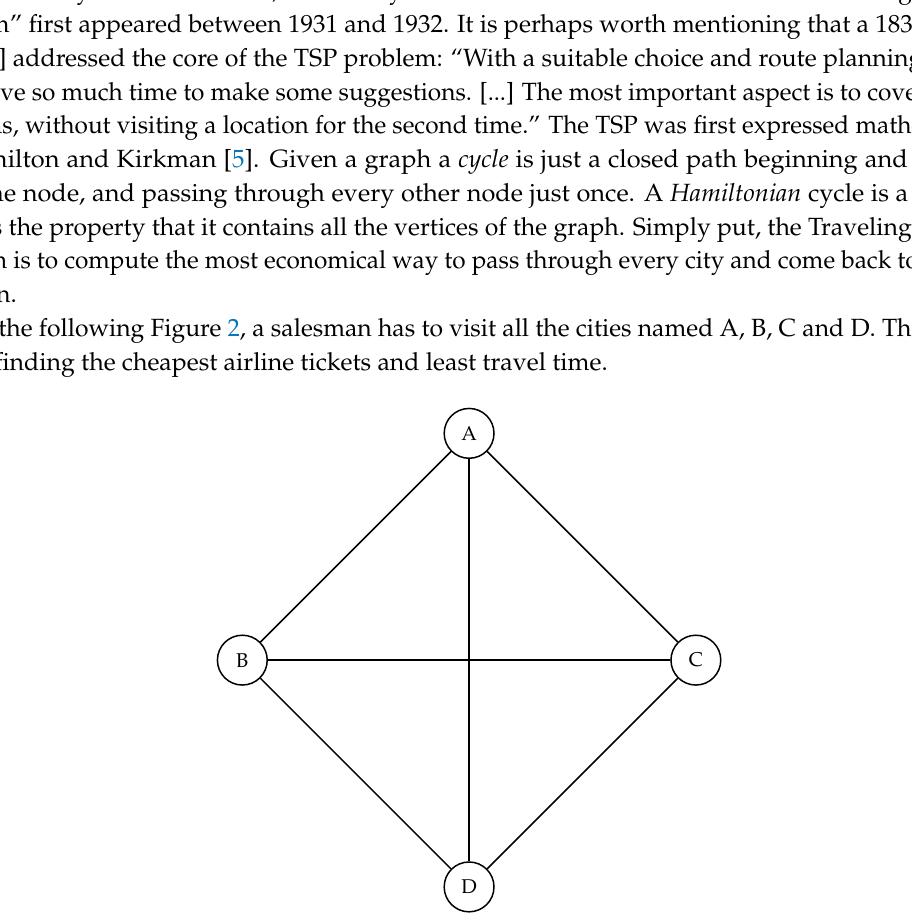
Figure 2. Example of a tour consisting of 4